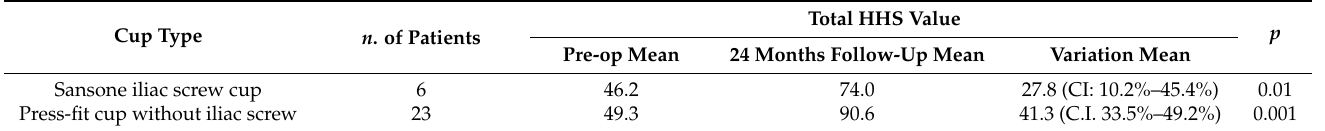
Table 9. Total HHS pre-op vs 24 months’ follow-up values in subgroups of cup type.